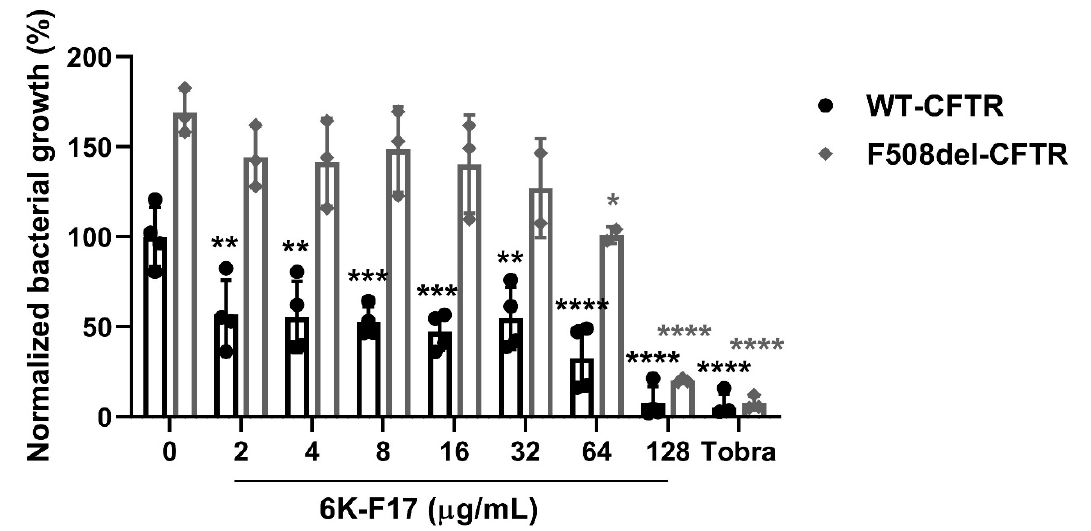
Figure 1. Antimicrobial activity of 6K-F17 on non-Cystic Fibrosis (CF) and CF epithelial cultures. HBE cells were co-cultured with PAO1 bacteria for 4 h with increasing concentrations of 6K-F17 peptide (0–128 µg/mL) or 10 µg/mL tobramycin antibiotic (Tobra). Live bacteria were quantified using the BacTitre-Glo Microbial Cell Viability assay (Promega) and normalized to bacterial growth on WT-human bronchial epithelial cells (WT-HBE) cells alone (0 bar). PAO1 growth on WT-cystic fibrosis transmembrane conductance regulator (WT-CFTR) is depicted by black bars, PAO1 growth on F508del-CFTR in grey bars. Significance is reported as follows: ns, not significant; * p < 0.05, ** p < 0.01; *** p < 0.001; **** p < 0.0001. Data shown represent the mean ± SEM ( n = 3, 4; each dot represents one biological replicate).